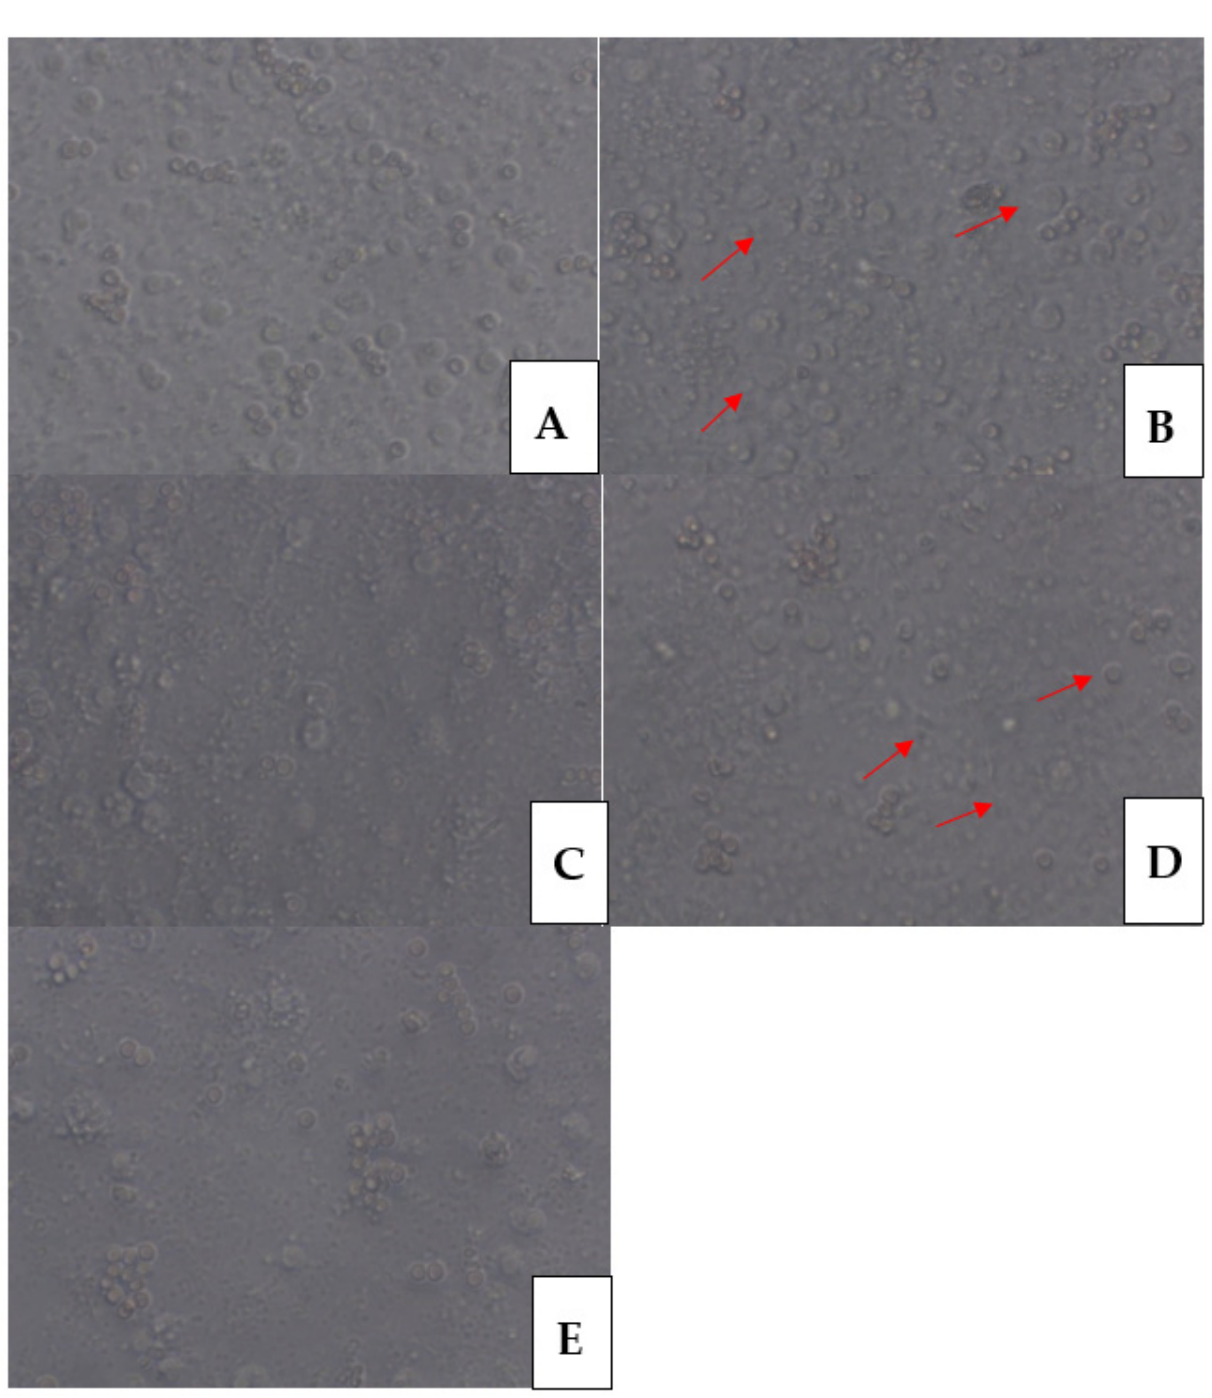
Figure 9. Representative phase contrast microscopical images revealing the effects of different stimulators on the morphology of the resulting macrophages after 3 days of culture. ( A ) MDMs left without any additional stimulation were described as BCS. ( B ) MDMs stimulated with ANE (40 μ g/mL). Black arrows indicate ‘fried egg’-shaped phenotype. ( C ) MDMs stimulated with LPS (1 μ g/mL). ( D ) MDMs stimulated with DGP. Red arrows indicate filopodia. ( E ) MDMs stimulated with DEX (100 nM). Original magnification ×40.